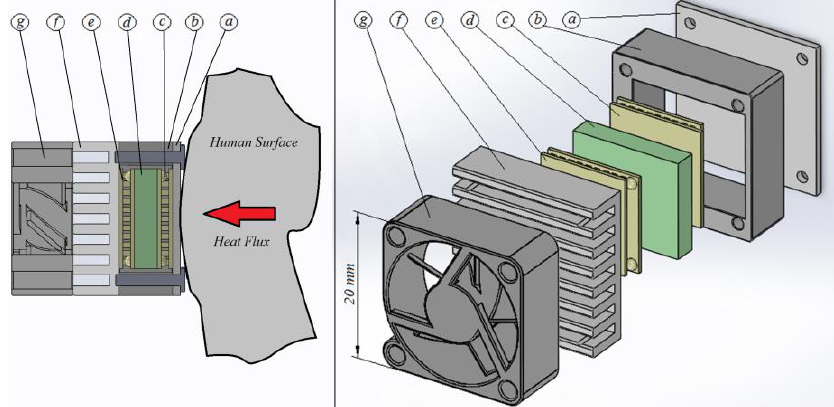
Figure 1. Cross-sectional diagram and exploded view of the calorimetry sensor: a (aluminium plate), b (thermal insulation), c (measurement thermopile), d (thermostat), e (cooling thermopile), f (aluminium heat sink) and g (fan).